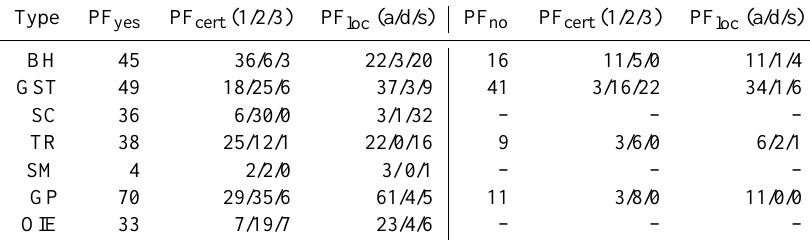
Table 3. Overview of the different observation types (BH: borehole, GST: ground surface temperature, SC: rock fall scar, TR: trench and construction site, SM: surface movement, GP: geophysical investigation, OIE: other indirect evidence) that remain for evaluation. For each type, the number of permafrost-existence (PF yes ) and permafrost-absence (PF no ) observations is given (Certainty levels PF cert : 1 definite proof, 2 quite certain, 3 quite likely; Agreement levels PF loc : a agree, d disagree, s strongly disagree).